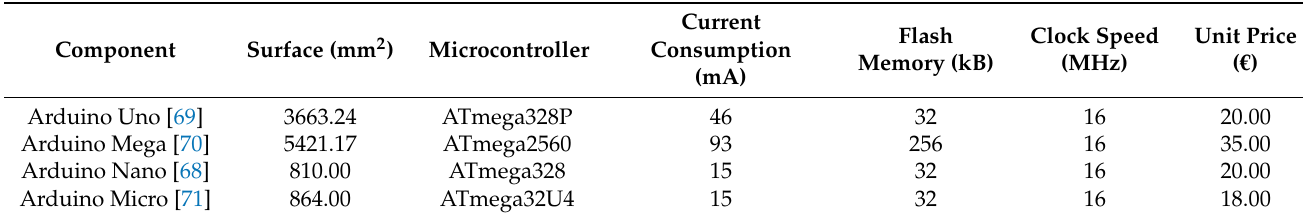
Table 1. Arduino family comparison.